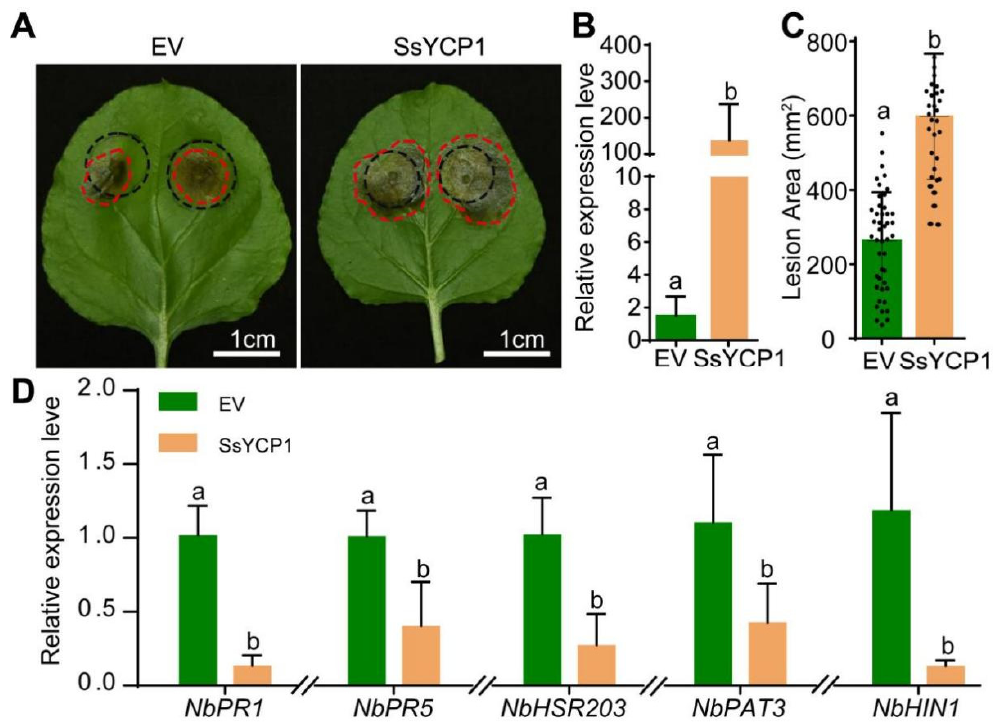
Figure 2. S. sclerotiorum infection is promoted by SsYCP1 overexpression. ( A ) Tobacco leaves expressing SsYCP1 were more susceptible to S. sclerotiorum . Leaves were infiltrated with Agrobacteria containing the p35S empty vector (EV) or p35S-SsYCP1 (SsYCP1) as indicated, and S. sclerotiorum was inoculated 48 h after agroinfiltration. Leaves were photographed after 48 h; representative images are shown. Black circles indicate the leaf area infiltrated with Agrobacteria , and red circles indicate S. sclerotiorum -induced infections. ( B ) The expression of SsYCP1 was significantly higher in tobacco leaves agroinfiltrated with p35S-SsYCP1 (SsYCP1) than in the control leaves (EV). Leaves were injected with S. sclerotiorum 48 h after agroinfiltration and analyzed by qPCR after 24 h. Data are means ± SD; n = 3; Different lowercase letters means p < 0.05 (one-way ANOVA followed by Duncan’s test). ( C ) Quantification of S. sclerotiorum -induced lesions shown in ( A ), measured by ImageJ. Data are means ± SD; n = 34; Different lowercase letters means p < 0.05 (one-way ANOVA followed by Duncan’s test). ( D ) The expression of plant defense-related genes was suppressed by SsYCP1. Leaves were inoculated with S. sclerotiorum 48 h after agroinfiltration with p35S-SsYCP1 (SsYCP1) or p35S empty vector (EV), and gene expression was analyzed by qPCR 24 h after S. sclerotiorum inoculation. Data are means ± SD; n = 3; Different lowercase letters means p < 0.05 (one-way ANOVA followed by Duncan’s test).